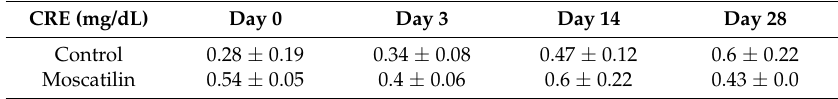
Table 2. Effects of treatment with control or moscatilin on creatinine levels. Data are presented as mean ±